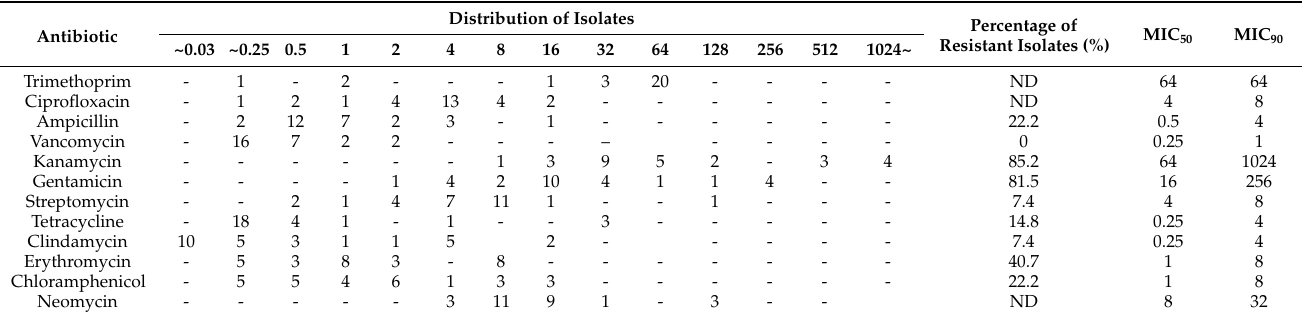
Table 2. Antimicrobial resistance profile of the F. prausnitzii strains isolated from healthy human feces. Antibiotic